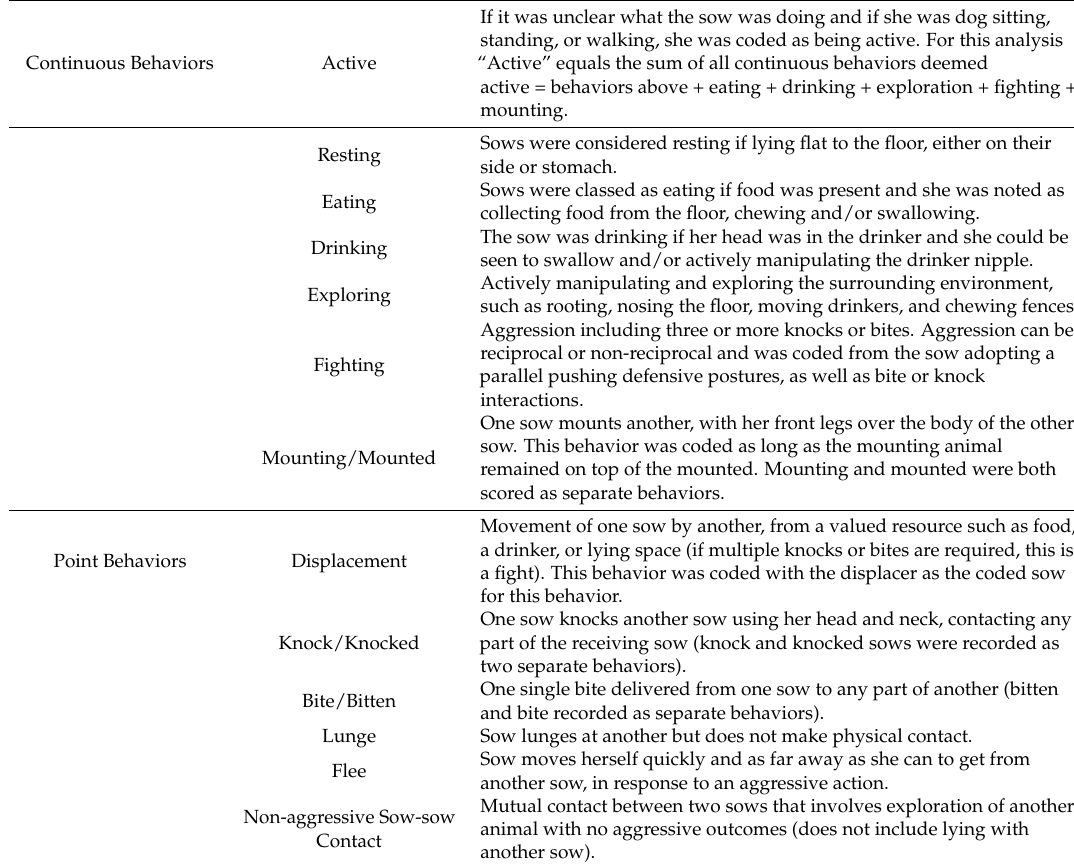
Table 2. Ethogram of continuous and point behaviors in group-housed domesticated sows as defined and used to analyse the behavior (Adapted from Greenwood et al., 2016)